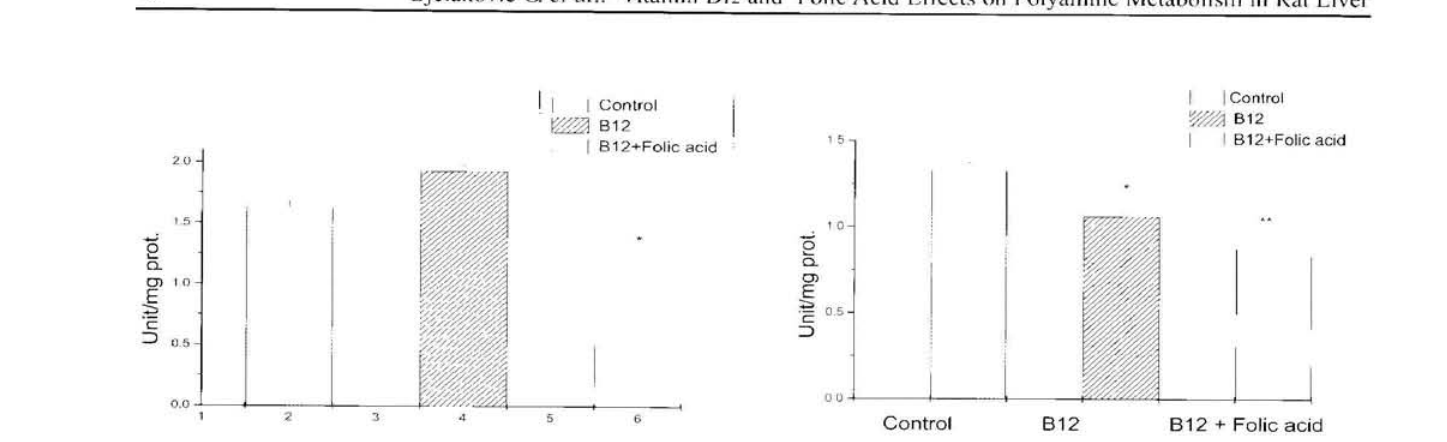
Figure 3. Diamine oxidase activity in liver tissue of rats treated with B12 and folic acid. Vitamin B12 in a single daily dose of 0.5 mg / animal i.m. during seven days. The second experimental group rcccived vitamin Β12 (in the same dose) plus folic acid (2.5 mg/animal) during seven days. Control group received 0.9 %